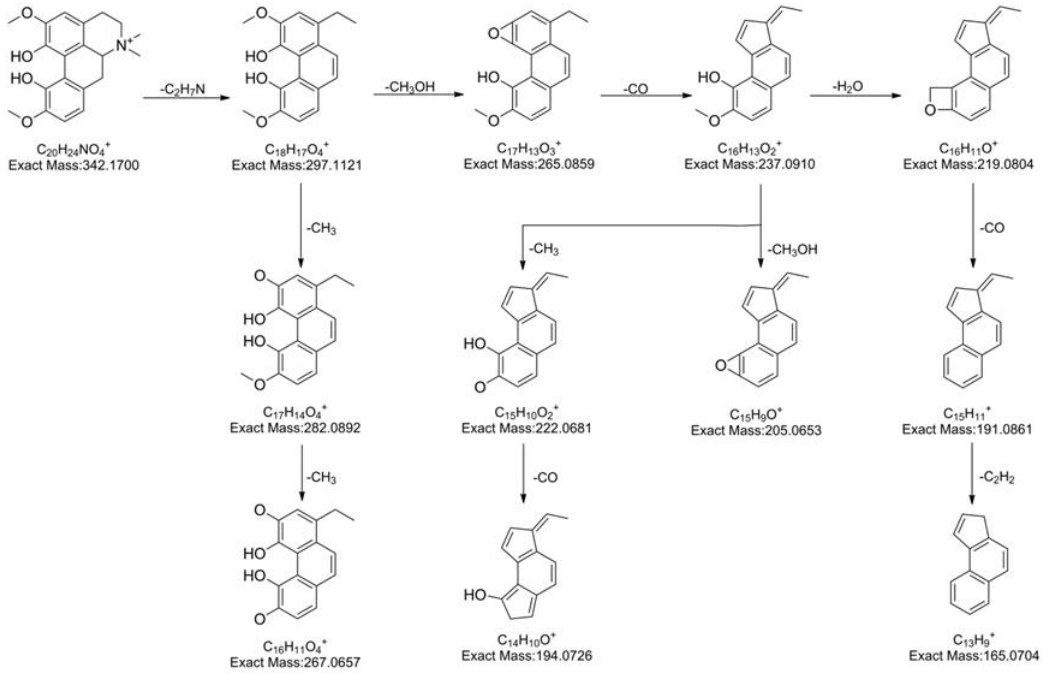
Figure 3. The proposed fragmentation pathway of magnoflorine. Molecules 2019 , 24 , x FOR PEER REVIEW